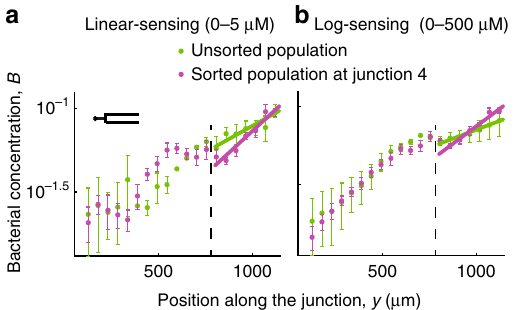
Fig. 4 Accumulation pro fi les of E . coli from an unsorted and a sorted population. The accumulation pro fi le of E . coli from the unsorted population (green) in the single-junction device is compared to the accumulation pro fi le of the sorted population (purple) at the last junction (junction 4) in the T-maze for the linear-sensing ( a ) and log-sensing ( b ) regime. The gradient generated over the single-junction device corresponds to that in the last junction of the T-maze. The fi tted slope of the bacterial accumulation pro fi le in the portion of the junction up the gradient (to the right of the dashed line) is shown for each case. Figures show mean ±